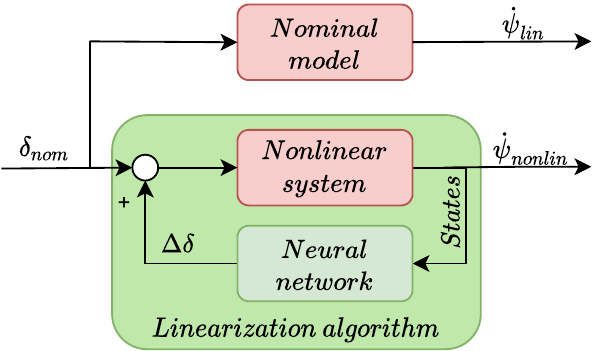
Figure 2. Illustration of the linearization algorithm.